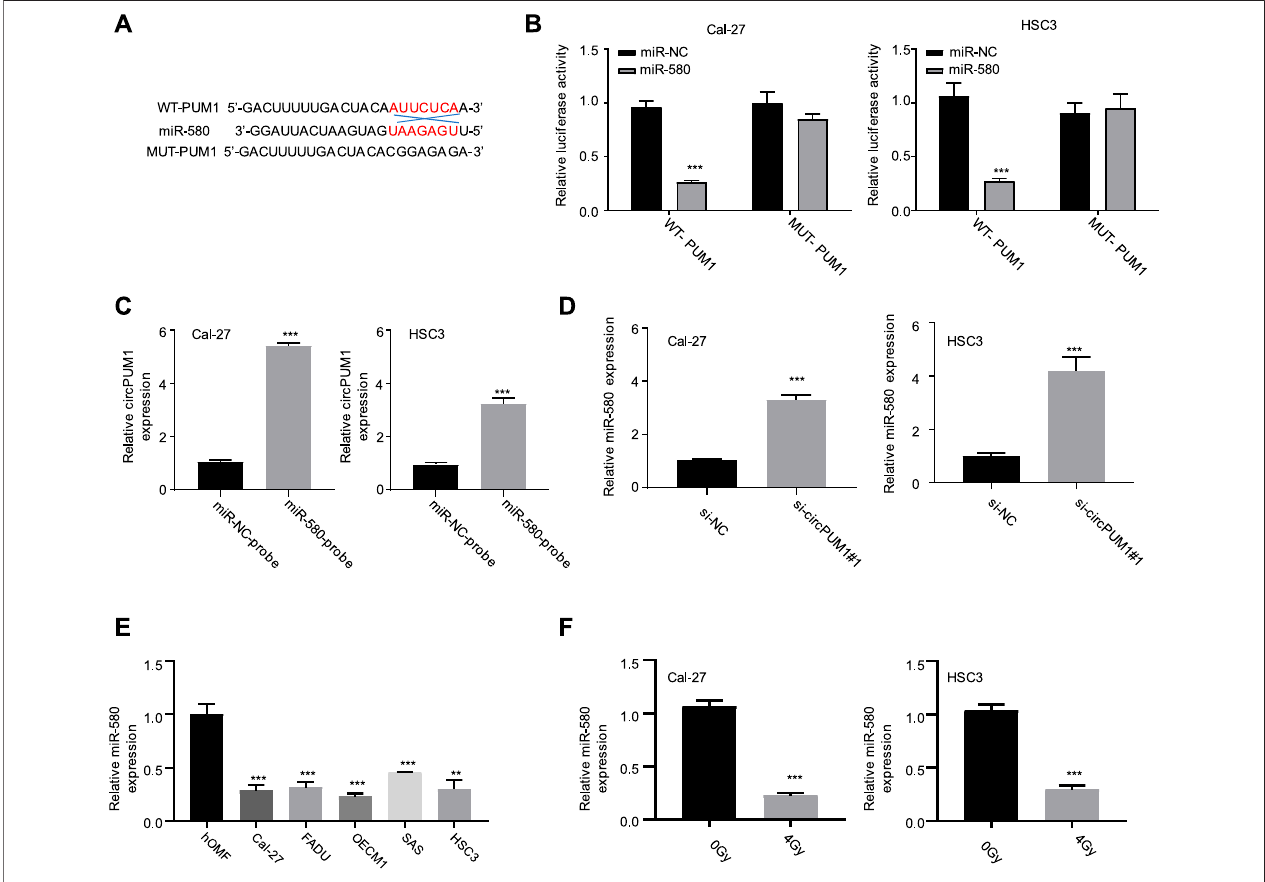
FIGURE3| BindingsiteofCircPUM1 andmir-580 (A) ;effectofmir-580ontheactivity ofCircPUM1 (B,C) ;relationshipbetweenknockdown ofCircPUM1andmir- 580 expression (D) ; expression level of mir-580 in the OSCC cell line (E) ; expression of mir-580 in OSCC cells after 4 Gy radiation (F) . p < 0.01 ( pp ) and p < 0.001 ( ppp ).